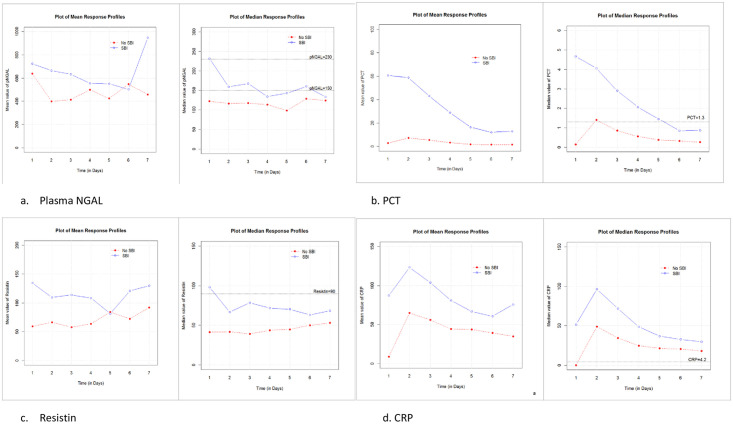
Longitudinal trends in mean and median biomarkers over first seven days of PICU admission.a. Plasma NGAL; b. PCT; c. Resistin; d. CRP.